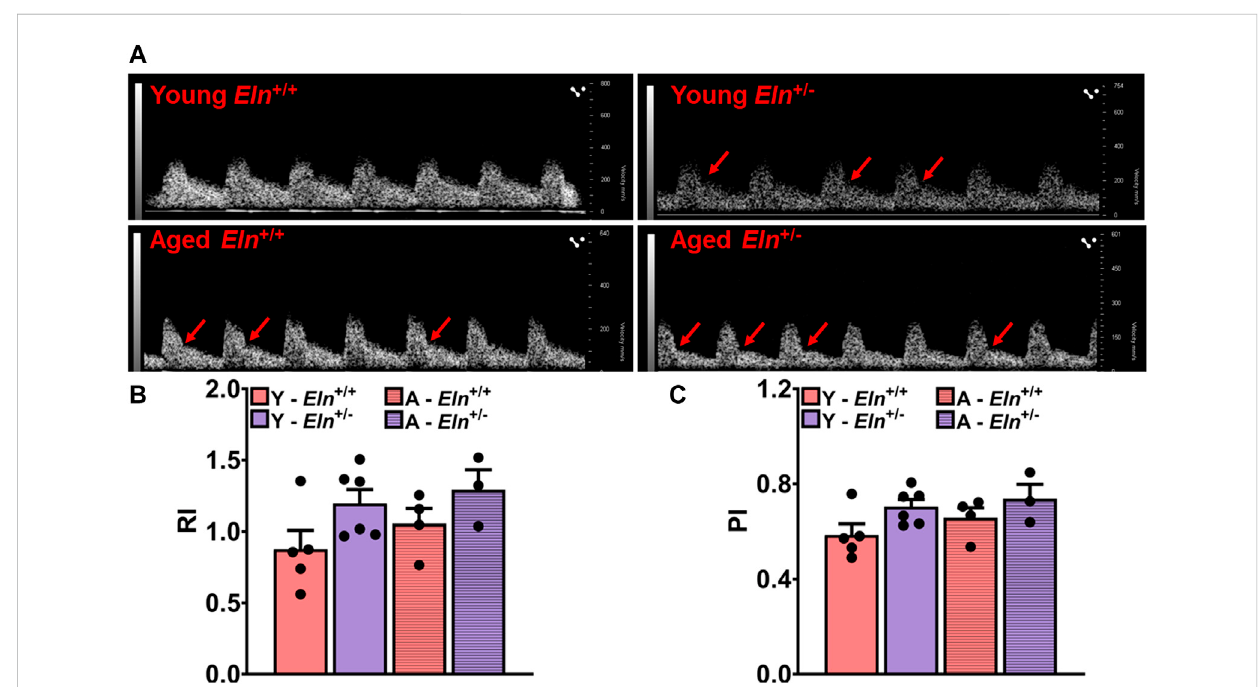
FIGURE 1 Doppler ultrasonography of renal arteries in anesthetized young and aged Eln +/+ and Eln +/ − mice. (A) Representative waveforms of renal artery Doppler ultrasound of young and aged Eln +/+ and Eln +/ − mice. Systolic notches (red arrows) can be seen in the waveforms of Eln +/ − mice of both age ) of Eln +/+ and Eln +/ − mice of both age groups ( n = 3 – 6 per group) was groups as well as in aged Eln +/+ mice. (B) Average resistive index, RI (cid:1) ( PSV − EDV PSV derived from peak systolic (PSV) and end diastolic (EDV) velocities of renal Doppler waveforms represented in 1A. (C) Average pulsatility index, ) of Eln +/+ and Eln +/ − mice of both age groups was derived from peak systolic, end diastolic, and mean (MV) velocities of renal Doppler PI (cid:1) ( PSV − EDV MV waveforms represented in 1A. All values in the bar graphs are mean ± s.e.m. Y, young; A,